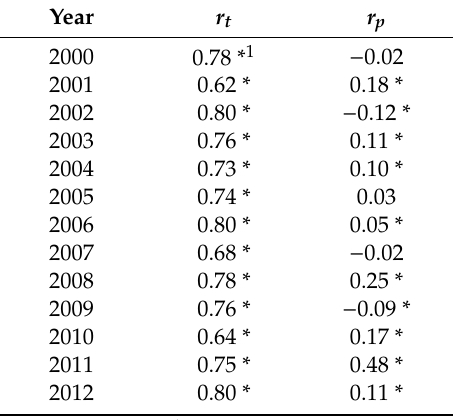
Table 4. Yearly partial correlation coe ffi cients between EOS and the mean temperature / accumulated precipitation during the optimum length periods. r t denotes the partial correlation coe ffi cient between the growing season end date and the mean temperature after eliminating the influence of accumulated precipitation; r p denotes the partial correlation coe ffi cient between the growing season end date and accumulated precipitation after eliminating the influence of the mean temperature. Year r t r p 2000 0.78 * 1 − 0.02 2001 0.62 * 0.18 * 2002 0.80 * − 0.12 * 0.76